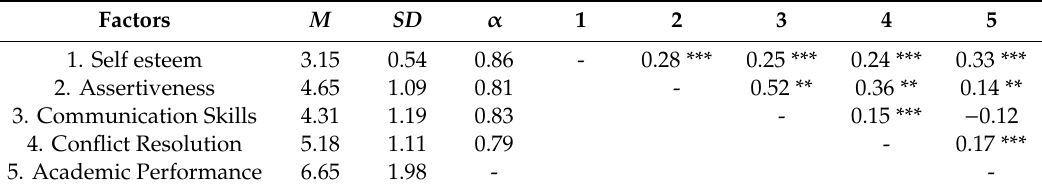
Table 1. Descriptive statistics and correlations between all variables.